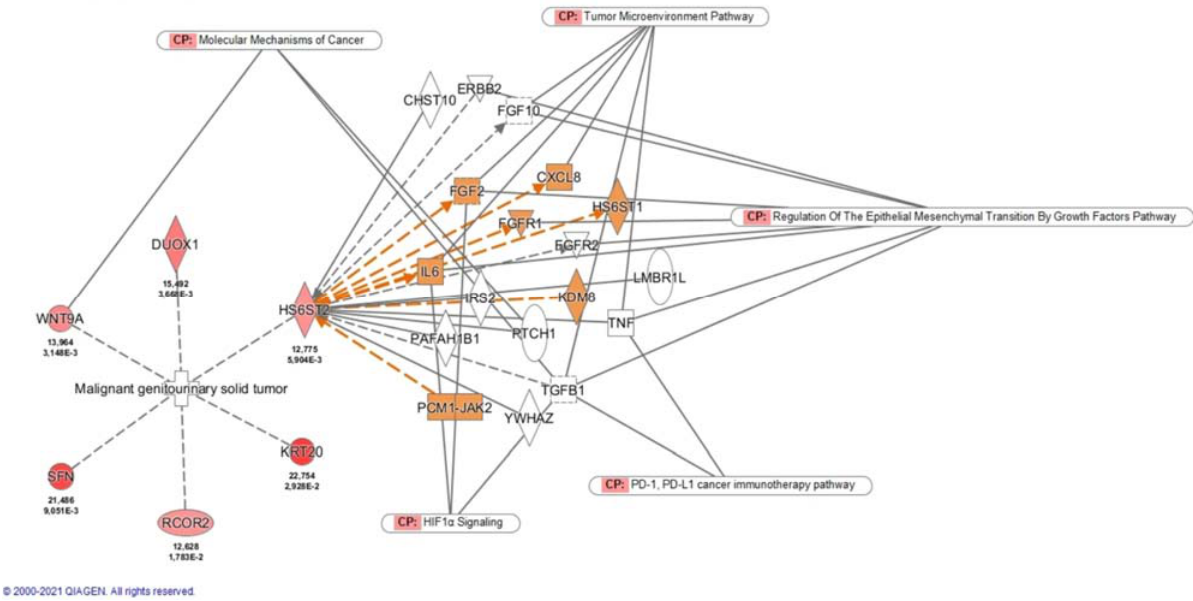
Figure 2. Disease and functions related to the validated genes and HS6ST2 significant molecular interactions and involved pathways. Abbreviations: CP, Canonical pathways.